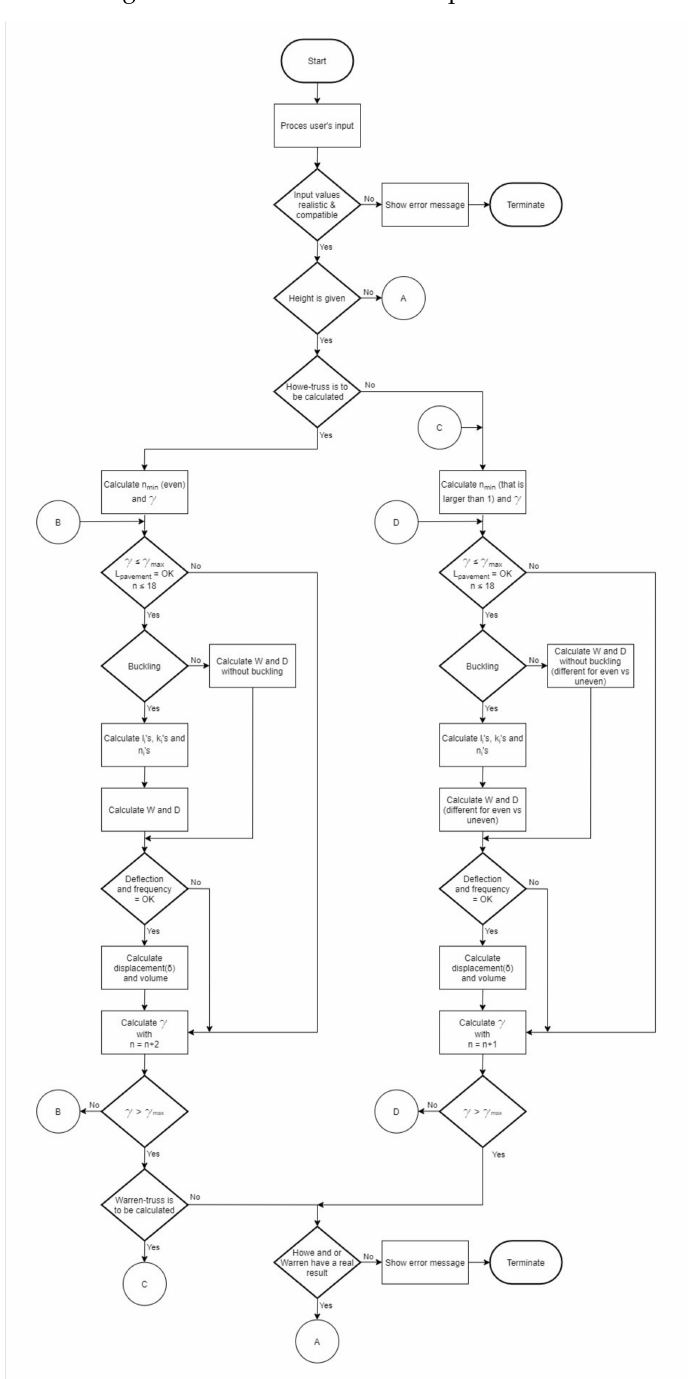
Figure 5. Flowchart software, part